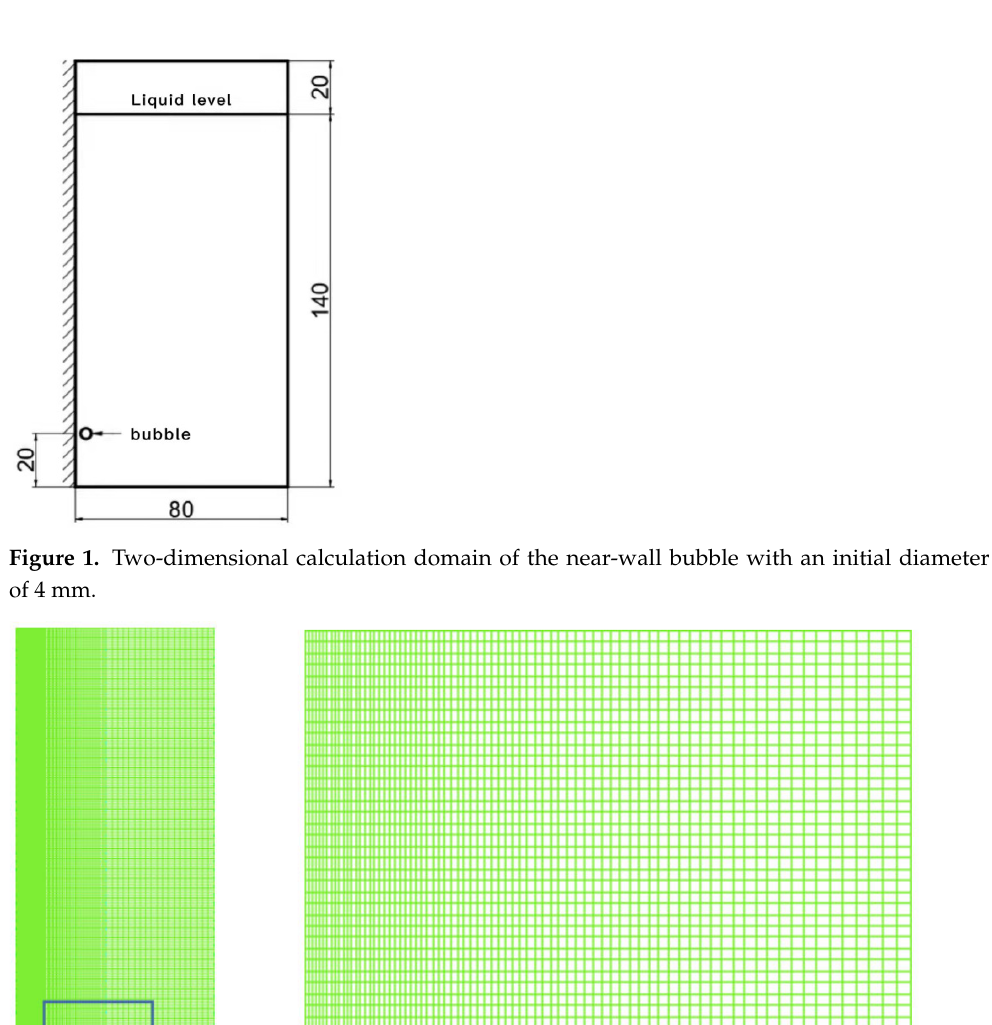
Figure 2. Global grid and local grid of 2D model.